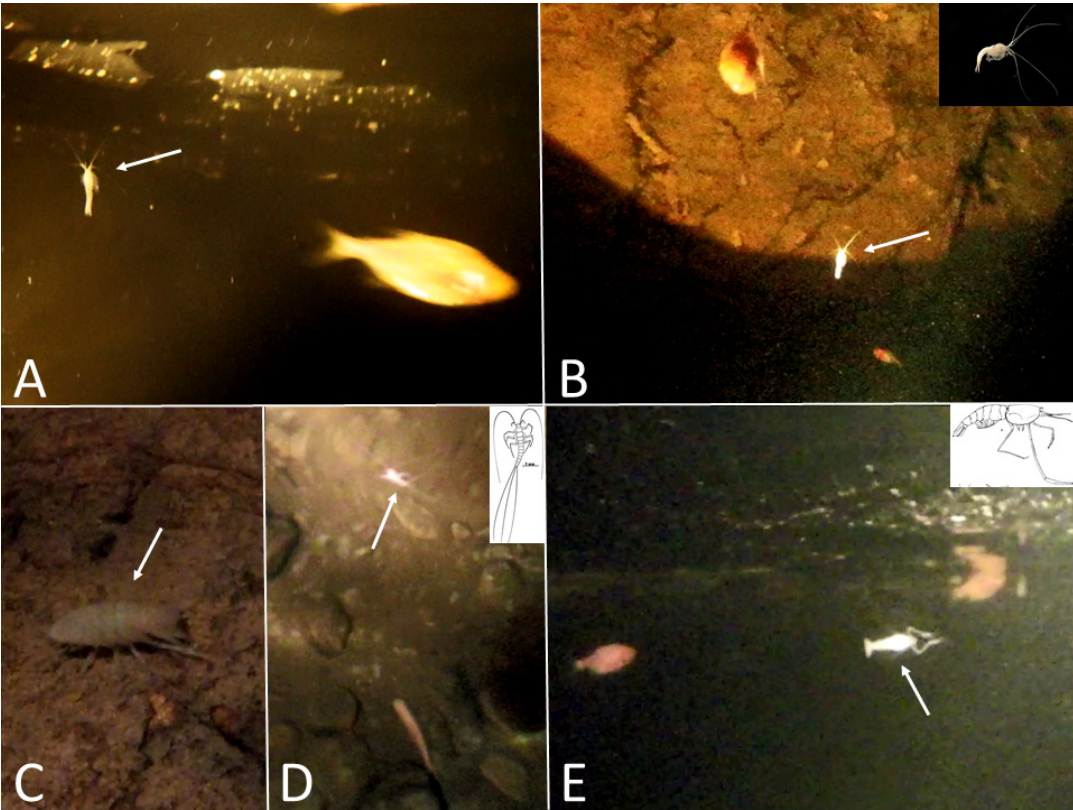
Figure 12. Stygobites and troglobites that cohabitate with Astyanax , but nonetheless were not seen to actively stimulate feeding behavior on the cavefish despite swimming less than 20 cm from them. ( A , B ); Mysid shrimp Spelaeomysis quinterensis . ( C ); Isopod Speocirolana pelaezi . ( D ); Nicoletiid insect Anelpistina quinterensis using surface tension to walk above water. €; Decapod shrimp Troglomexicanus perezfarfantae . ( A ), Cueva de Los Sabinos. ( B – E ), Sótano de la Tinaja. Inserts in ( B , D , E ) show higher quality images of organisms of the same genus. All photos were taken in the field. Arrows point to the arthropods.